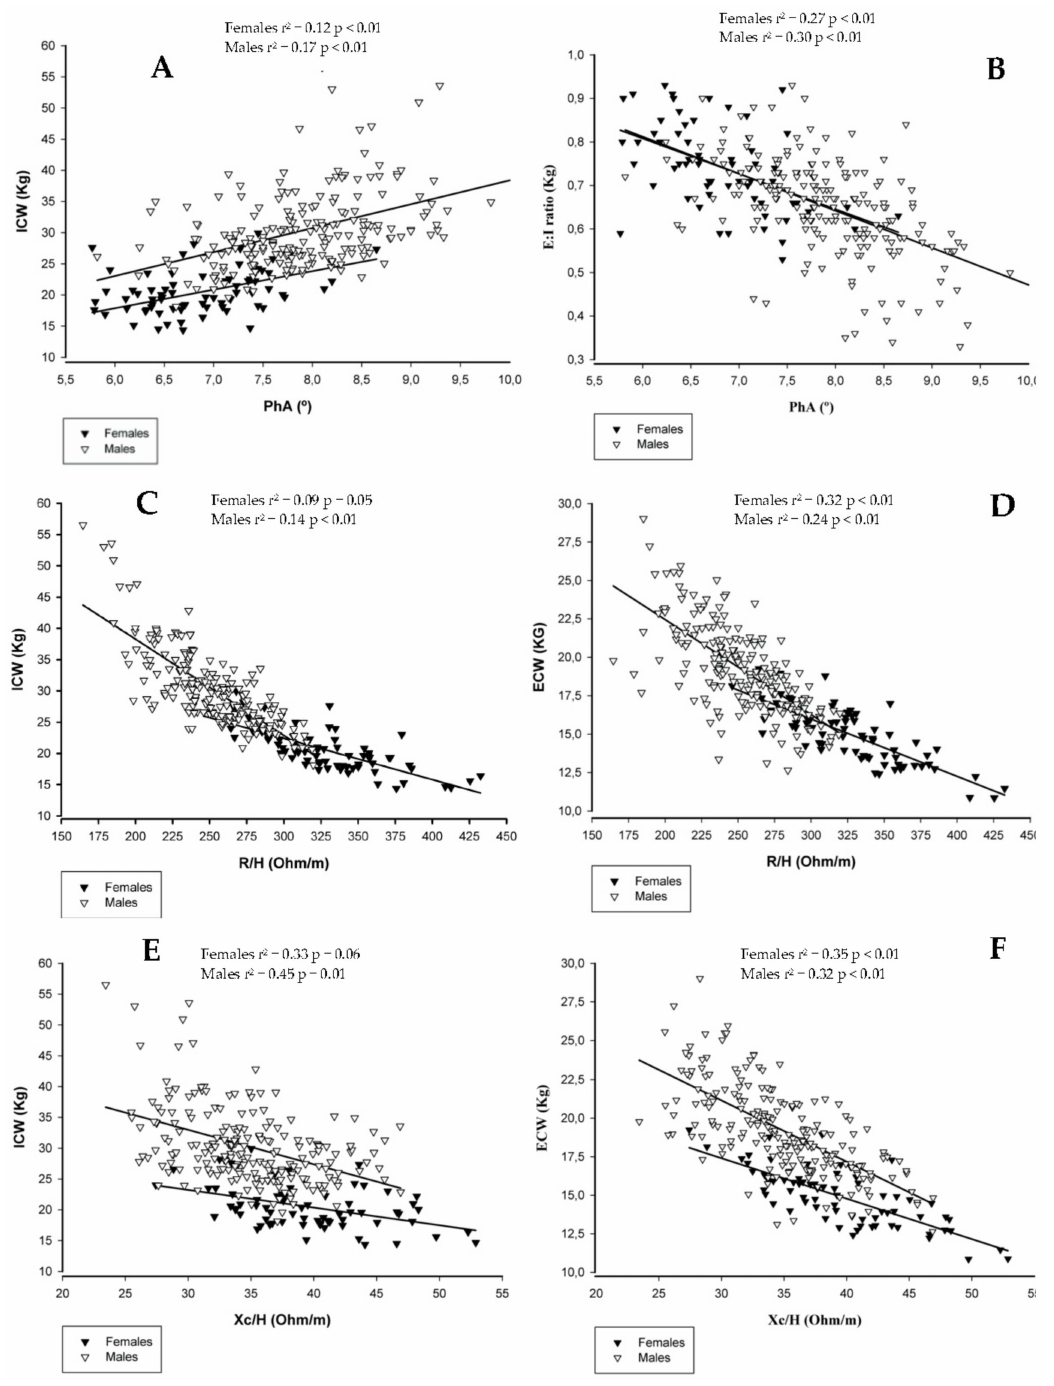
Figure 1. The independent association of BI parameters with fluid-related variables assessed through dilution techniques. Panel ( A ): PhA vs ICW; Panel ( B ): PhA vs E:I ratio; Panel ( C ): R / H vs ICW; Panel ( D ): R / H vs ECW; Panel ( E ): Xc / H vs ICW; Panel ( F ): Xc / H vs ECW. Abbreviations: PhA, phase angle; R / H, ratio between resistance and height (m); E:I ratio, ratio between extra-to-intracellular water; Xc / H, ratio between reactance and height (m); ECW, extracellular water; ICW, intracellular